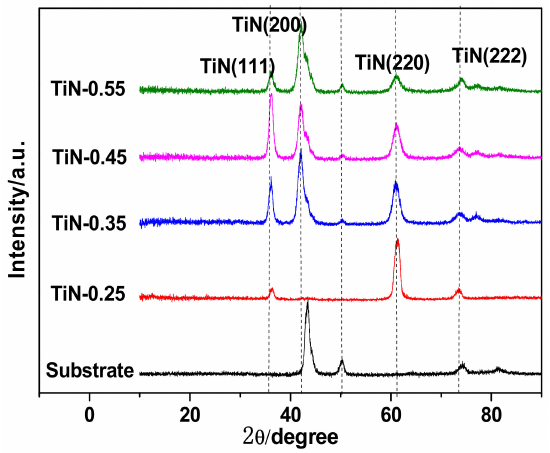
Figure 1. XRD pattern of the TiN